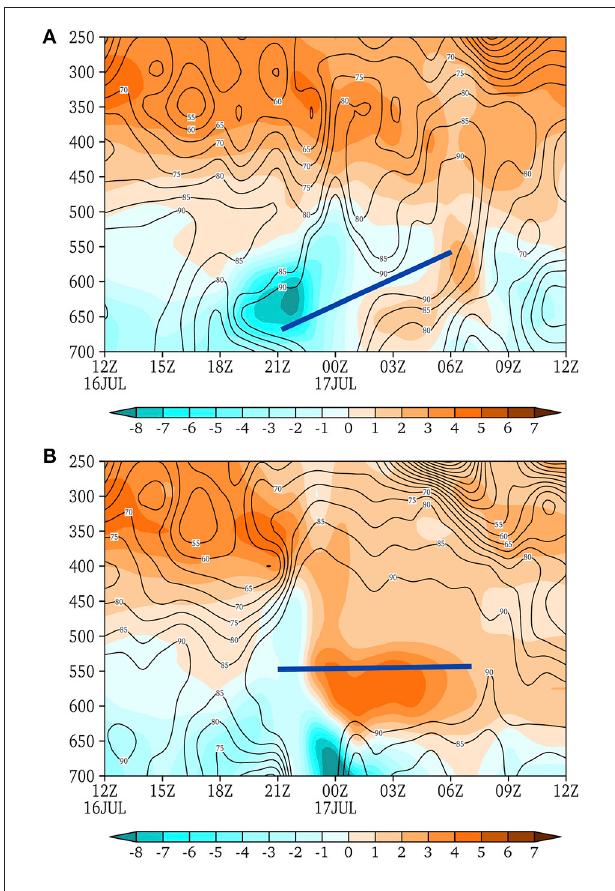
FIGURE 14 | Atmospheric stability for Mexico City between 12:00 UTC 16 July and 12:00 UTC 17 July 2014: (A) KF parameterization; (B) BMJ parameterization. Shading: δ 2 e/ δ p (K/mb) Contours: relative humidity